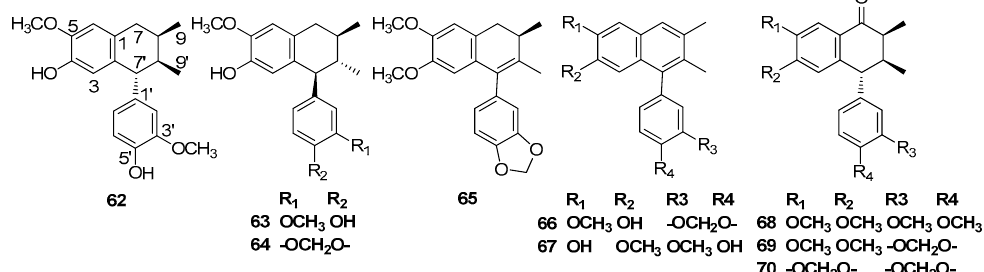
Figure 6. Chemical structures of 2,7’-cyclolignans.